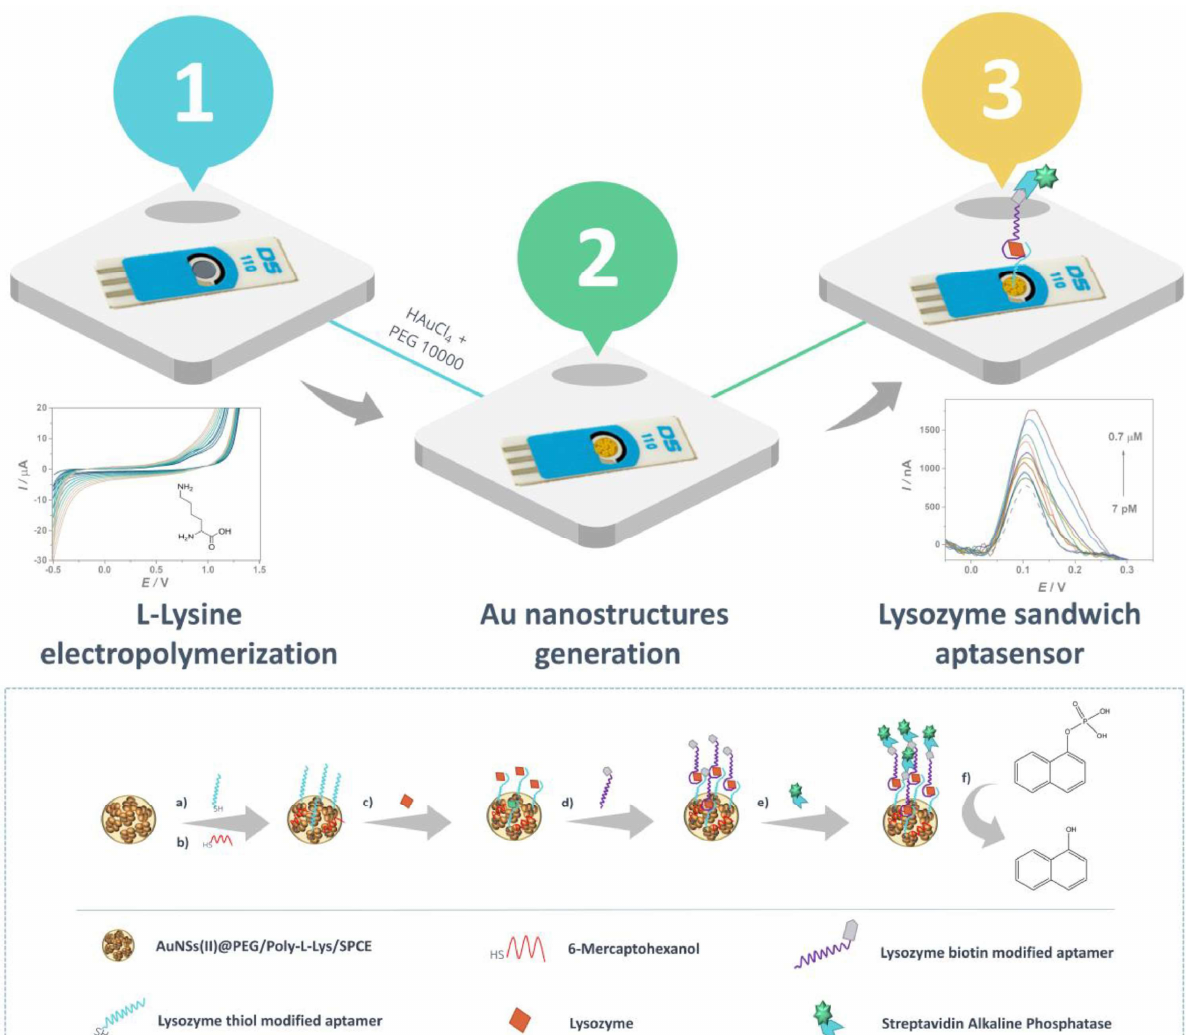
Figure 12. Scheme of the aptasensor assembly and the corresponding sensing mechanism. Reprinted with permission from [144]. Copyright 2022,